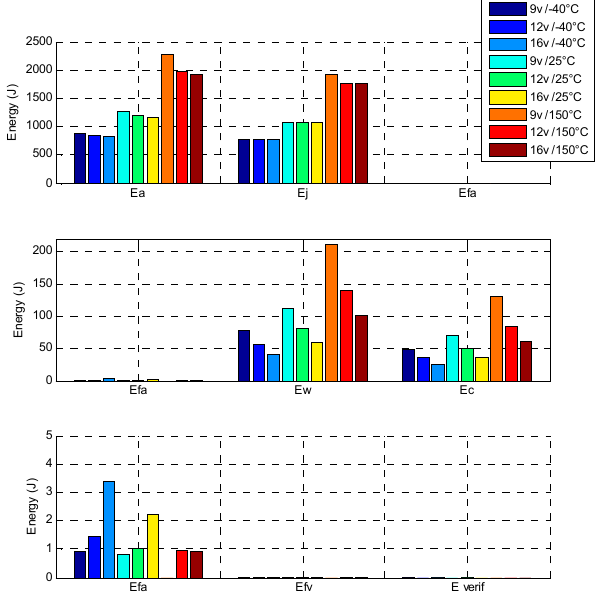
Figure 21. Direct drive energy balance at different voltages and temperatures. E a : the electrical energy consumption; E j : the Joule effect losses; E fa : the actuator mechanical losses; E w : the wire joule losses; E c : the H-bridge Joule losses and E fv : the valve mechanical losses.